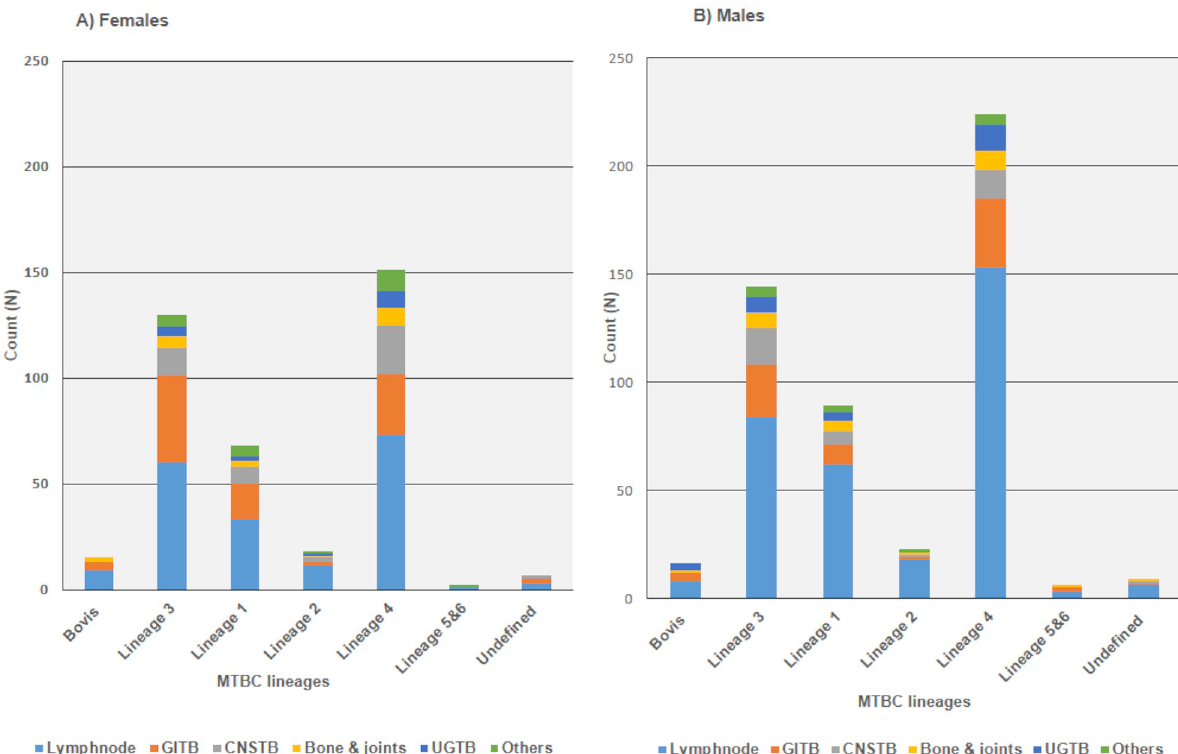
Fig 2. Gender, site of infection and MTBC lineages. Gastrointestinal TB (GITB), Central nervous System TB (CNSTB) and Urogenital TB (UGTB) were abbreviated as illustrated. Pericardial, skin and soft tissue, blood and oral TB were all grouped as others.